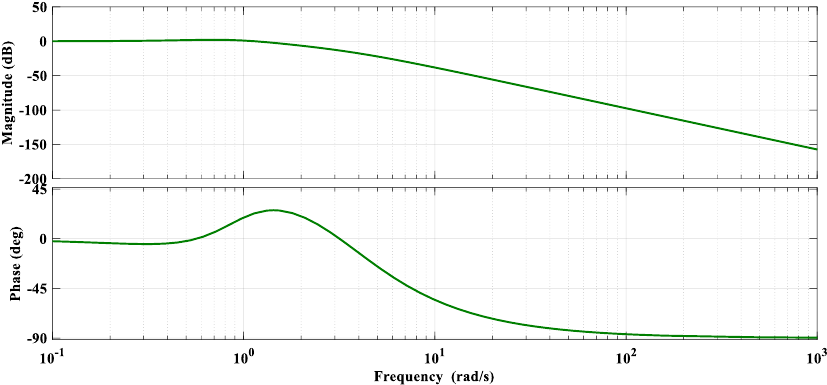
Figure 4. Closed-loop frequency response of an LFC system containing an EV aggregator with time-varying delay.